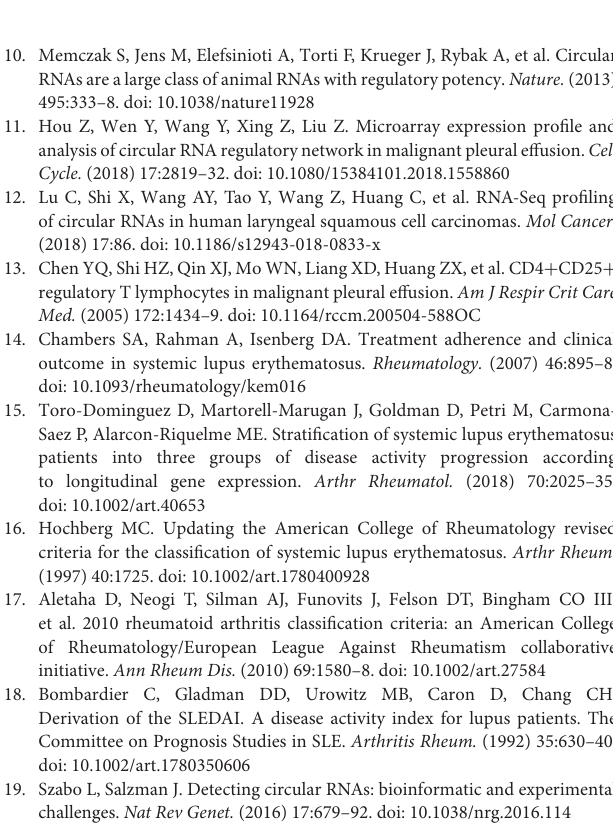
Supplementary Table 5 | The prediction of target gene of has-circ-0000497 ceRNA. Supplementary Table 6 | Most relevant networks of the target gene of